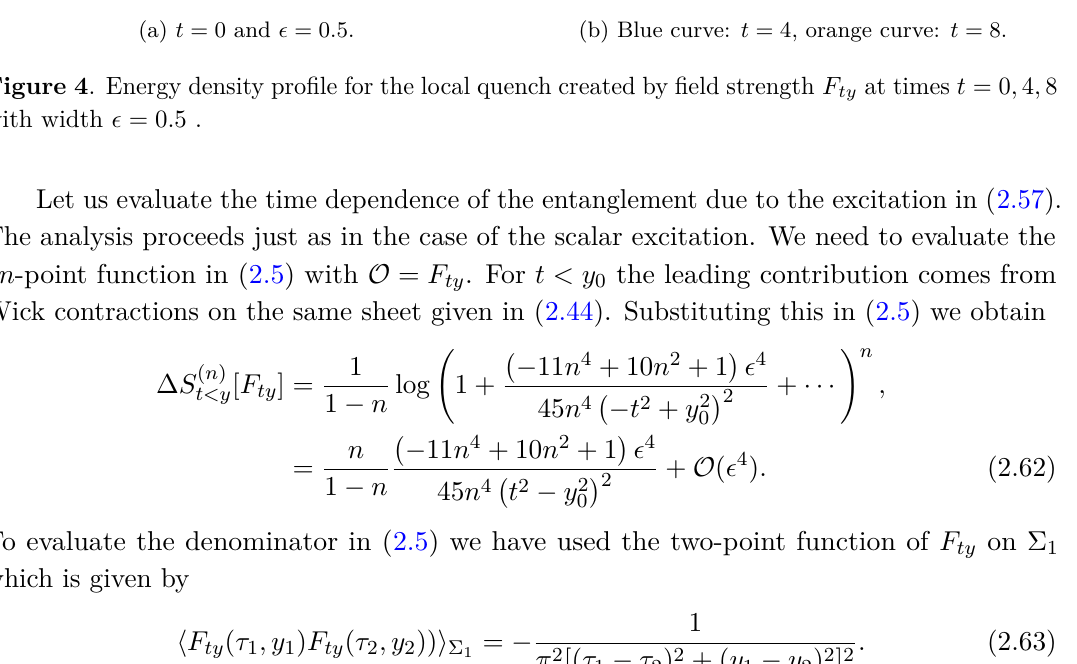
(b) Blue curve: t = 4 , orange curve: t = 8 .